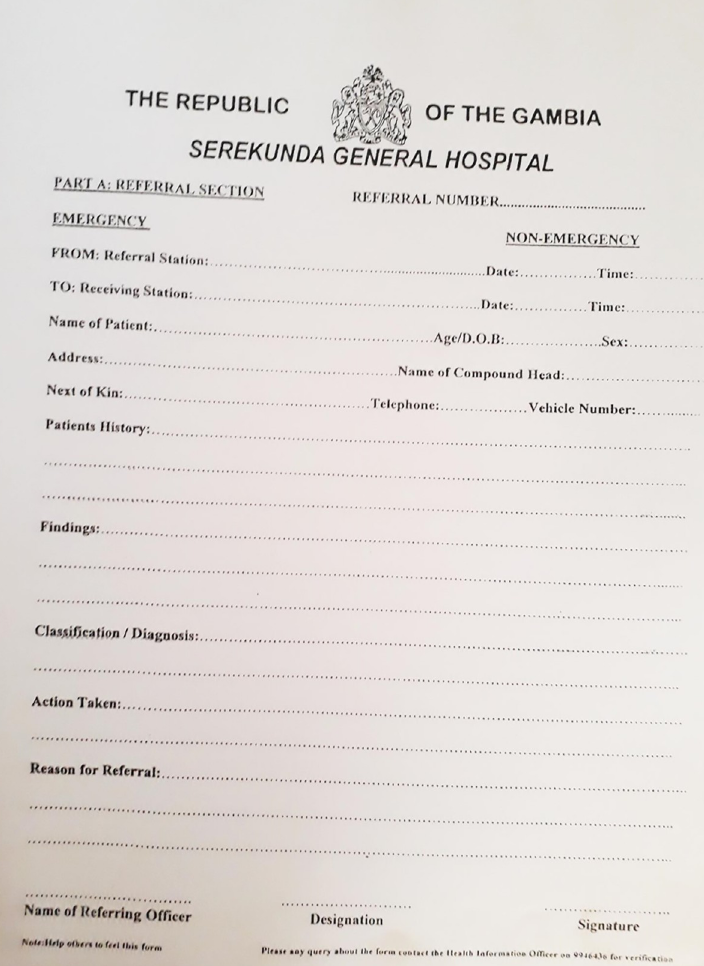
Fig 4. Structured referral sheet. Each hospital (and many of the health centres that referred to the hospitals) had centre-specific sheets designed for external referral. All had similar section headings, but documents were not standardised by the government (unlike the maternity